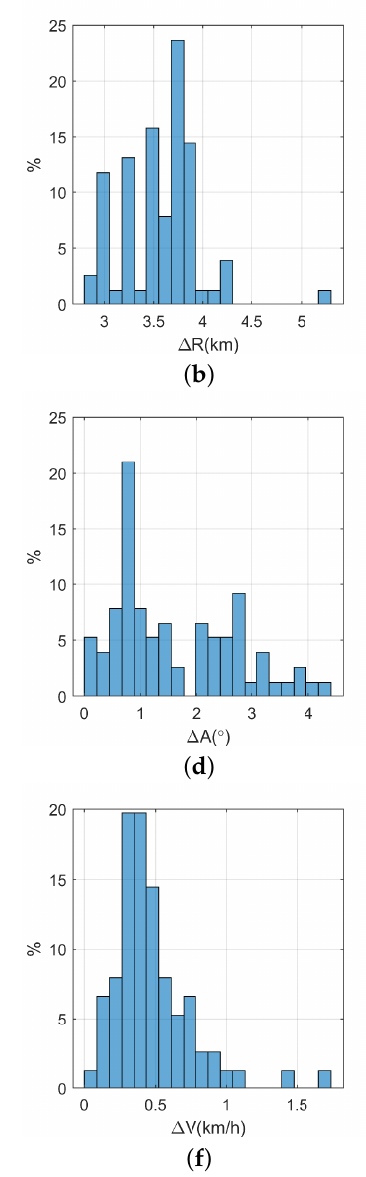
Figure 7. Kinematic parameter error distributions for target 1. ( a ) Range error distribution for monostatic radar. ( b ) Range error distribution for bistatic radar. ( c ) Azimuth error distribution for monostatic radar. ( d ) Azimuth error distribution for bistatic radar. ( e ) Doppler velocity error distribution for monostatic radar. ( f ) Doppler velocity error distribution for bistatic